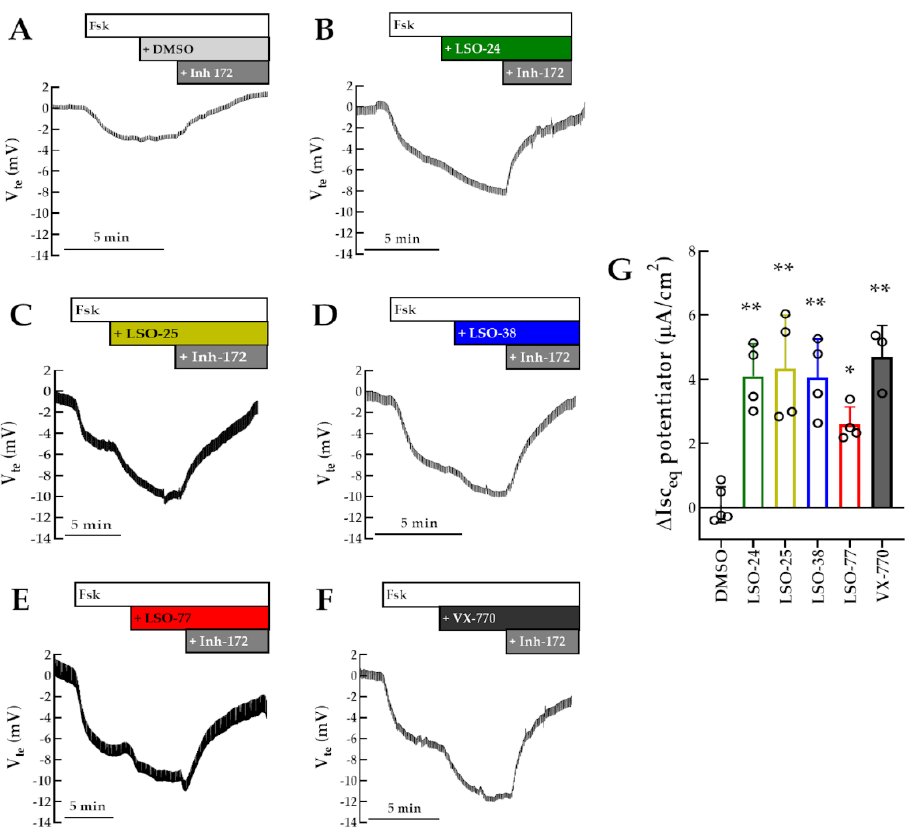
Figure 3. Assessment of compounds on R334W-CFTR function by micro-Ussing chamber mea- surements. ( A – F ) Representative Ussing chamber (open-circuit) recording representing transepithe- lial voltage measurements (V te ) of polarized monolayers of CFBE cells expressing R334W-CFTR. Cells were acutely subsequently stimulated with Fsk (0.128 µ M), test compounds (DMSO, 5 µ M LSO-24, 5 µ M LSO-25, 5 µ M LSO-38, 10 µ M LSO-77, or 3 µ M VX-770) and CFTRInh-172 (30 µ M). ( G ) Data are represented as mean (+ SD) increase in I eq promoted by test potentiator: * p < 0.05 and ** p < 0.01 vs.